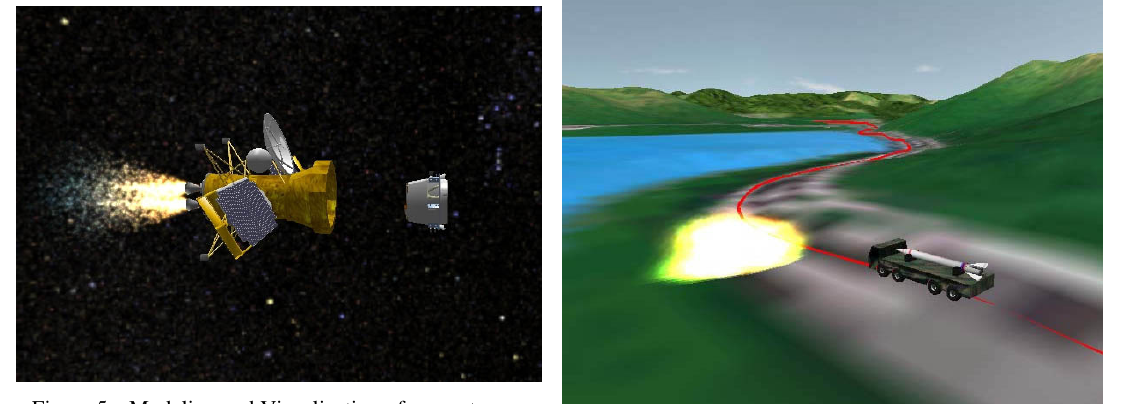
Figure 5c. Modeling and Visualization of geometry and interior action of deep space detector